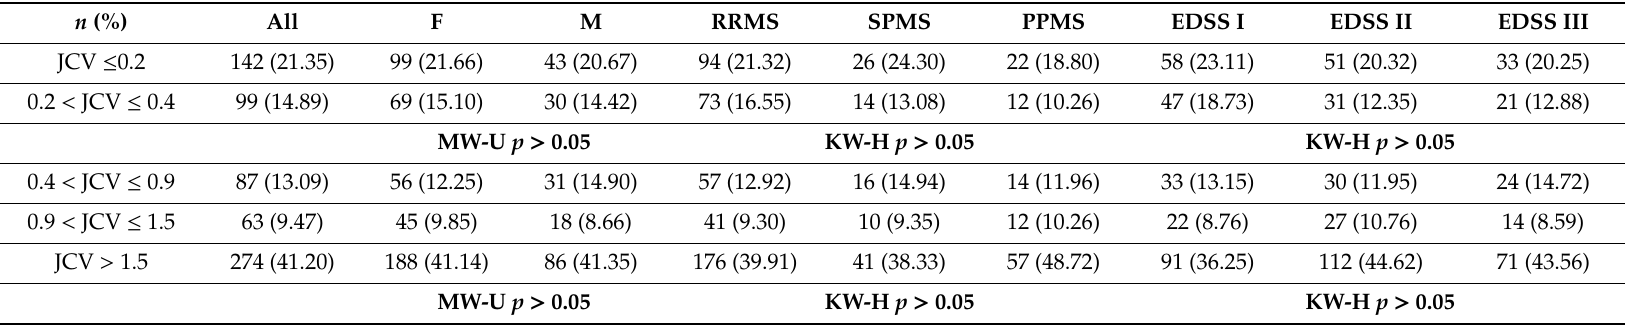
Table 5. Anti-JCV antibodies index categories and sex, clinical course, and EDSS score.